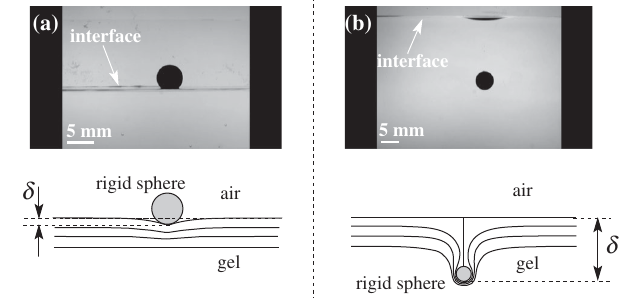
FIG. 1. Snapshots and schematics of the experiment. (Top panels) Side views of two transparent cells filled with a poly- acrylamide gel with shear modulus 1160 Pa (a) and 13 Pa (b). Two identical steel beads (5 mm diameter) have been placed on the free air-gel interface. The vertical downshifts are, respectively, δ ¼ 0 . 03 δ δ ¼ 320 δ 0 and 0 . (Bottom panels) Schematic repre- sentation of the deformation fields in the respective